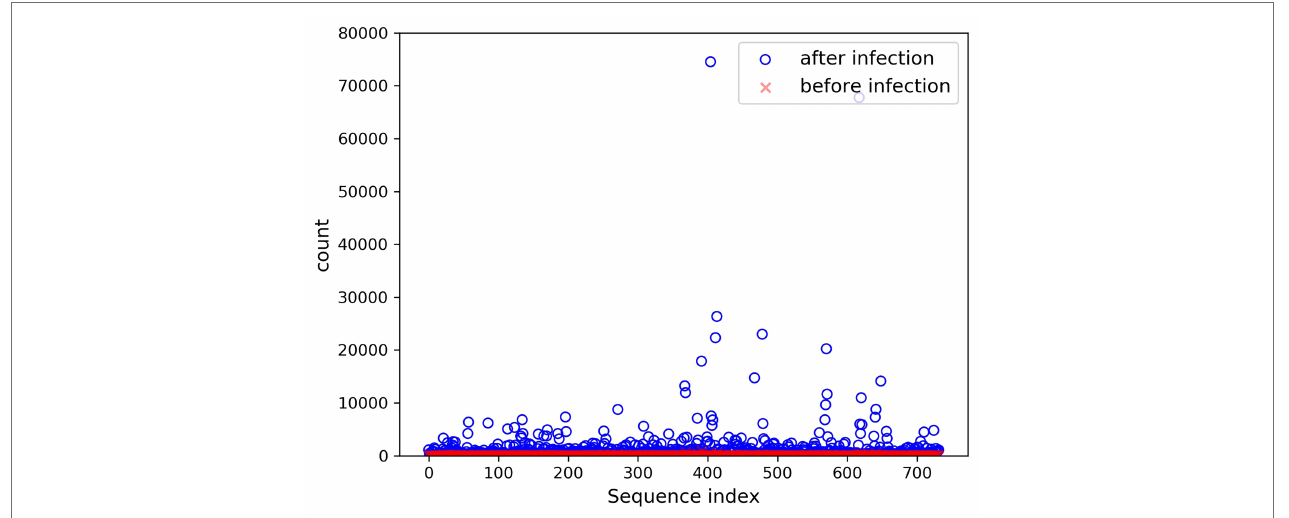
FIGURE 5 | Seven hundred thirty-two changes in expression before and after